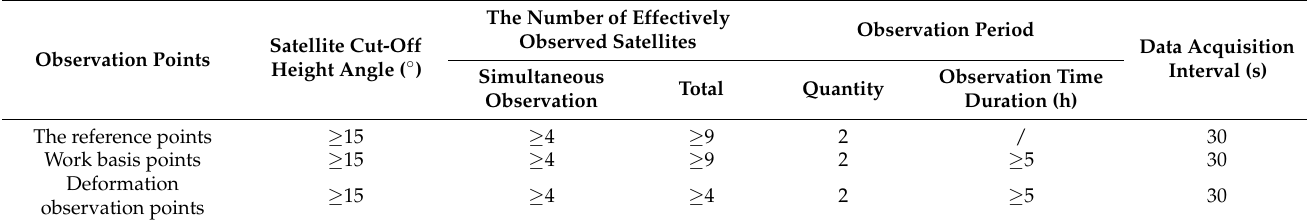
Table 1. Observation requirements of the three-level monitoring network.